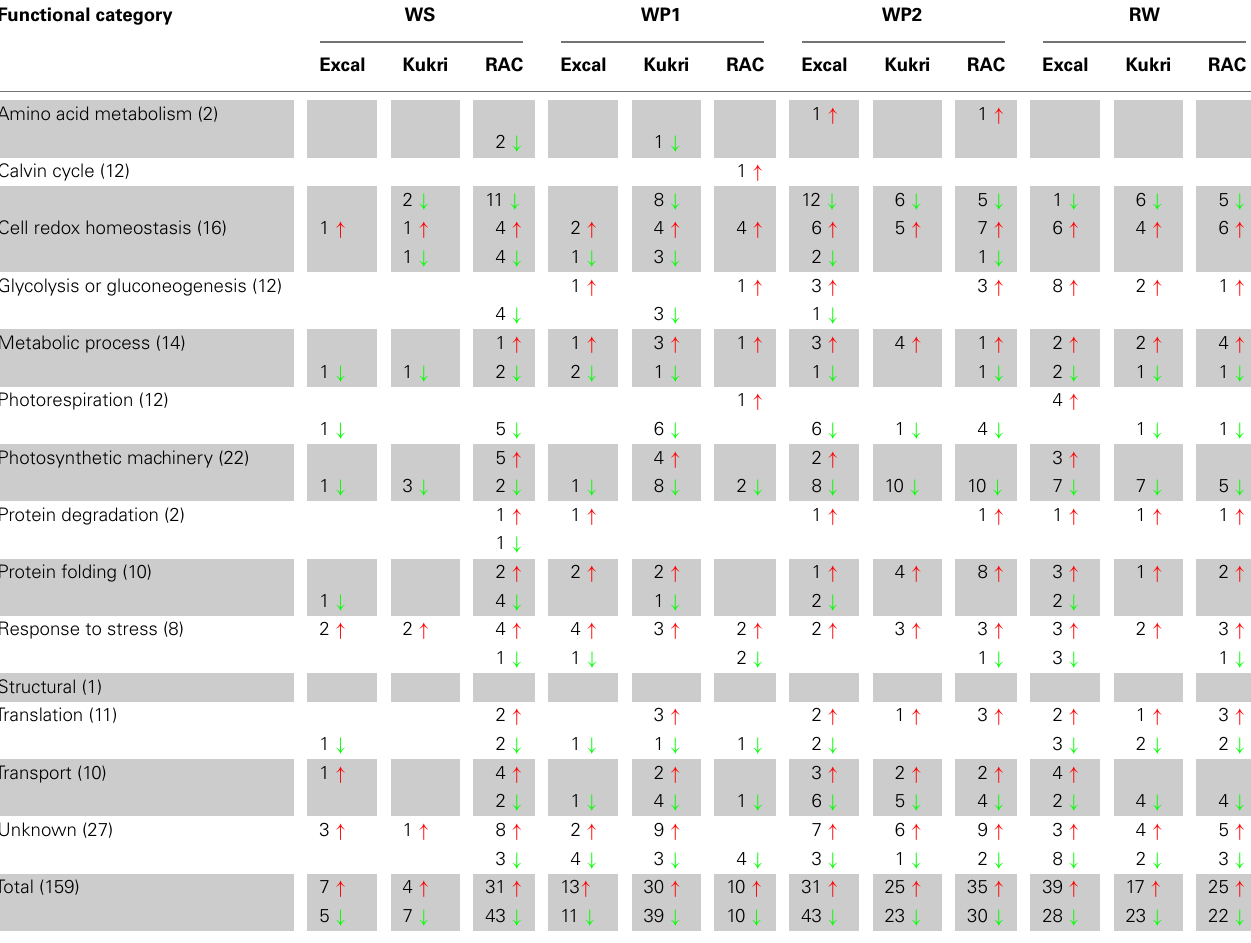
Table 1 |The data fromTable S2 in Supplementary Material of the 159 proteins identified by iTRAQ as changing during drought stress are summarized according to functional categories, increases indicated by ↑ in red, decreases indicated by ↓ in green. Functional